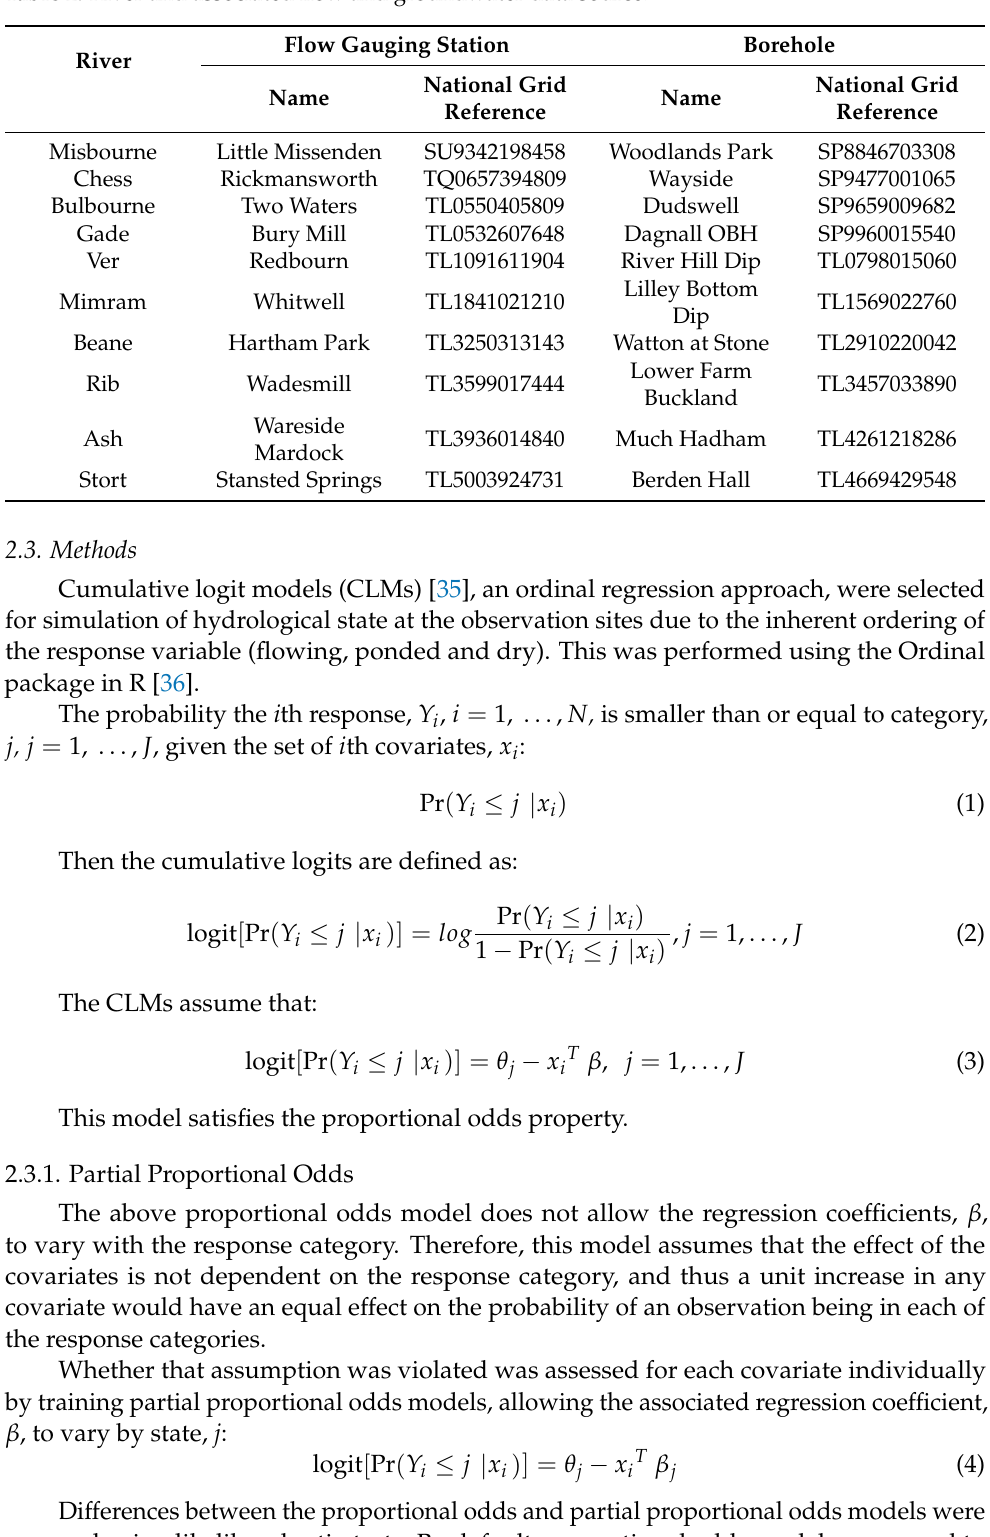
Table 2. River and associated flow and groundwater data